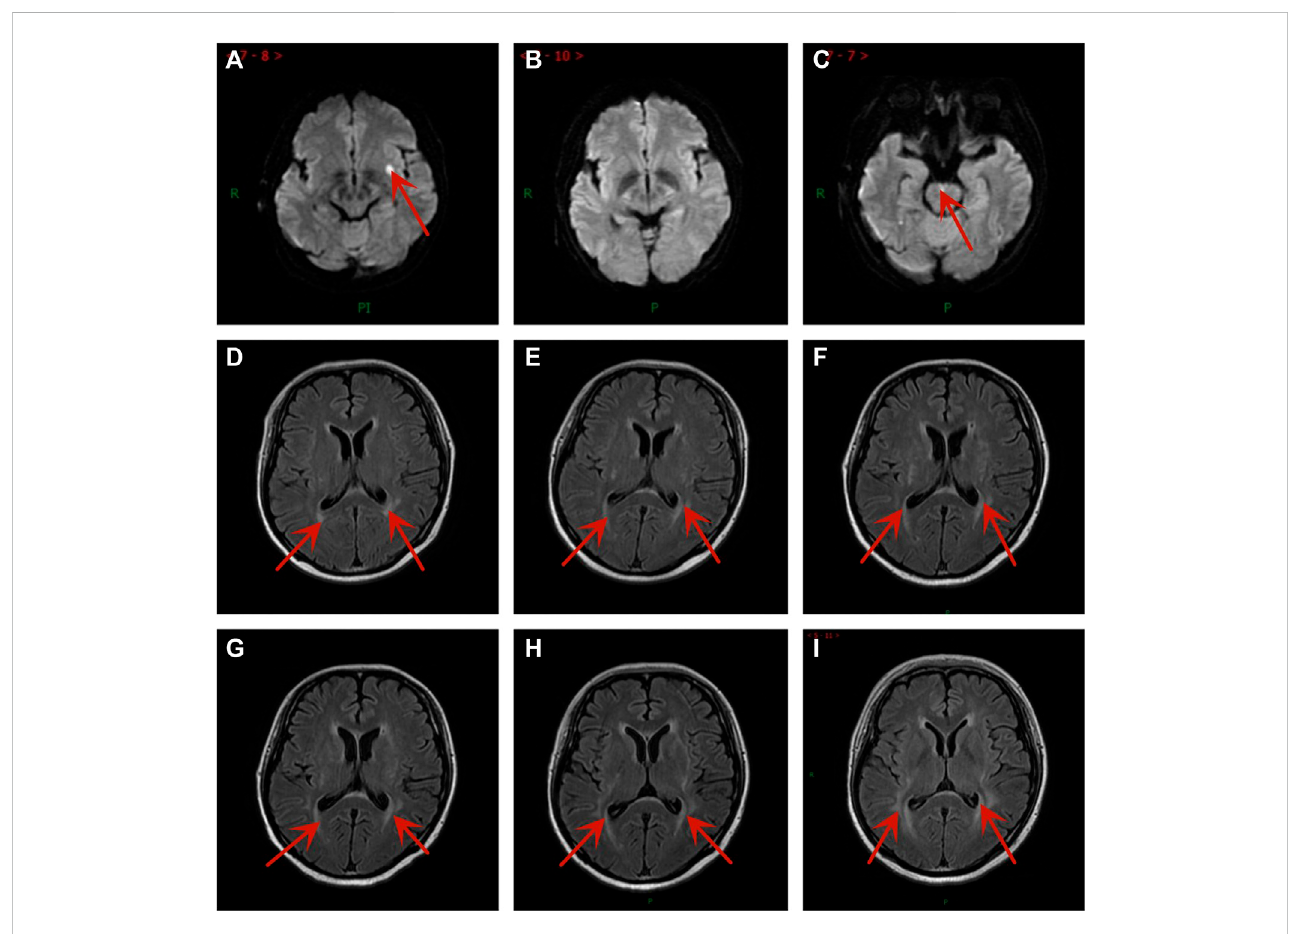
FIGURE 1 Brain magnetic resonance imaging images at different time points. (A) Brain metastases were newly diagnosed after second-line treatment. (B) One month after brain radiation therapy. (C) New brain metastasis after taking anlotinib 10 cycles. The PRES developed gradually after taking anlotinib for (D)